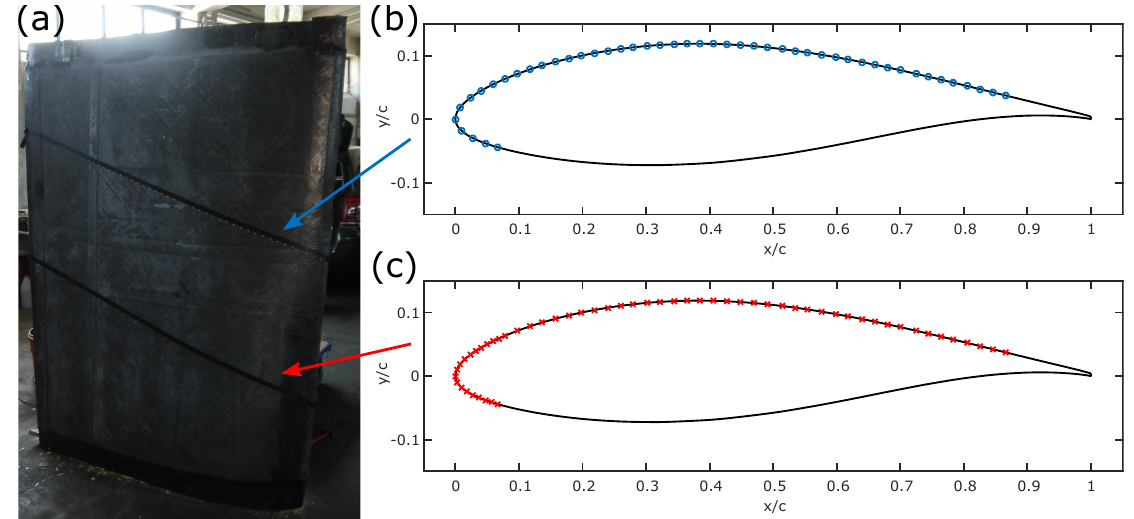
Figure 3. Position of sensors: ( a ) positions on the glove; ( b ) position of microphones; ( c ) positions of pressure